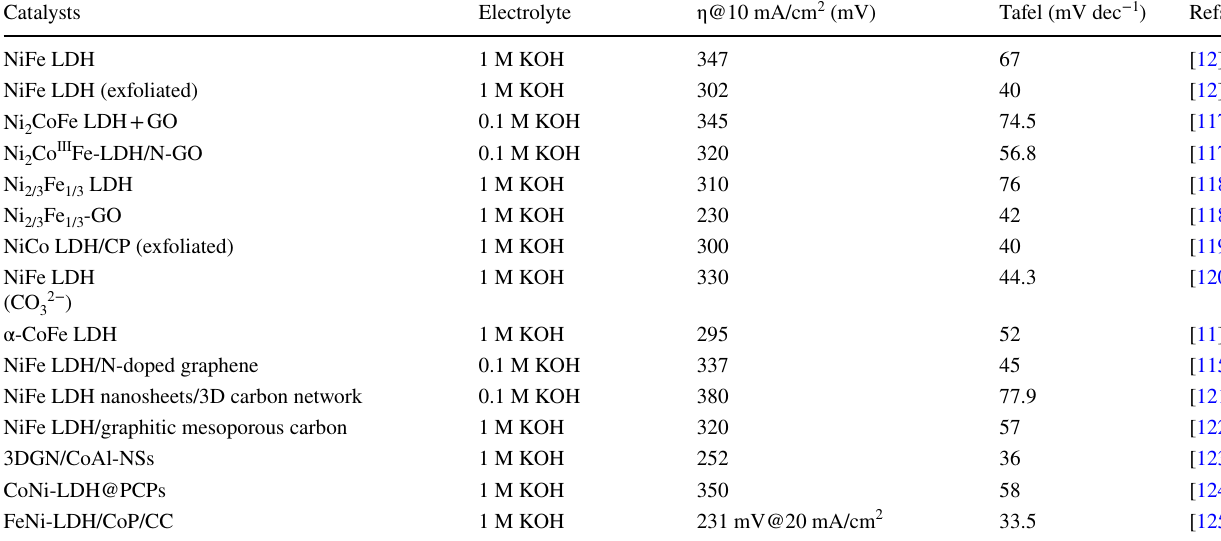
Table 1 Comparison of OER activities of different catalysts Catalysts